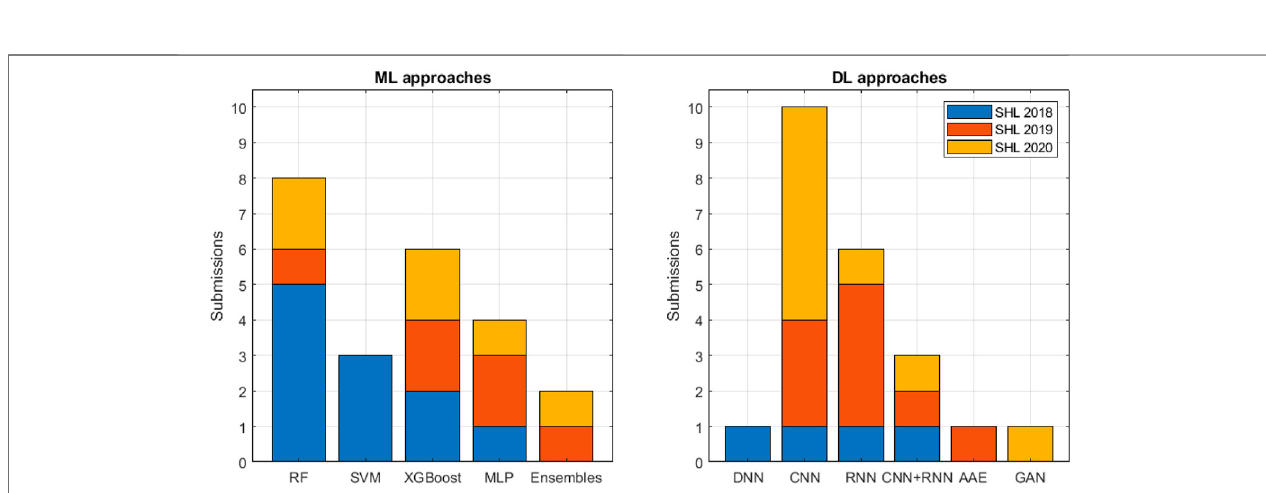
FIGURE 12 | Speci fi c classi fi er employed by classical machine learning and deep learning approaches in SHL 2018 – 2020.